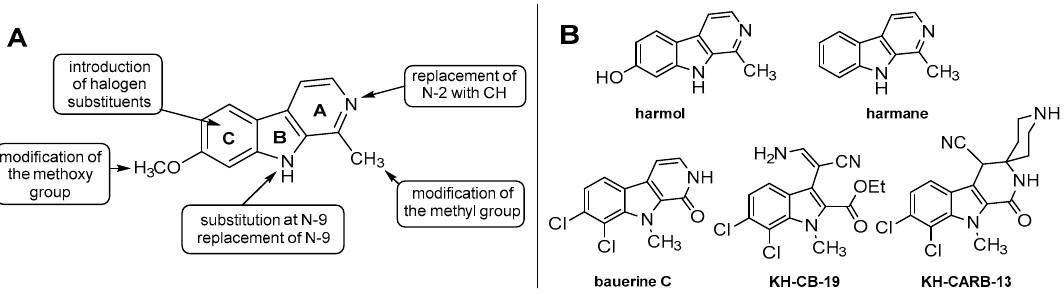
Figure 2. ( A ) Intended modifications of harmine. ( B ) Related alkaloids harmol and harmane, and kinase inhibitors with the uncommon dichloroindole / dichloro- β -carboline motif: bauerine C and synthetic kinase inhibitors derived